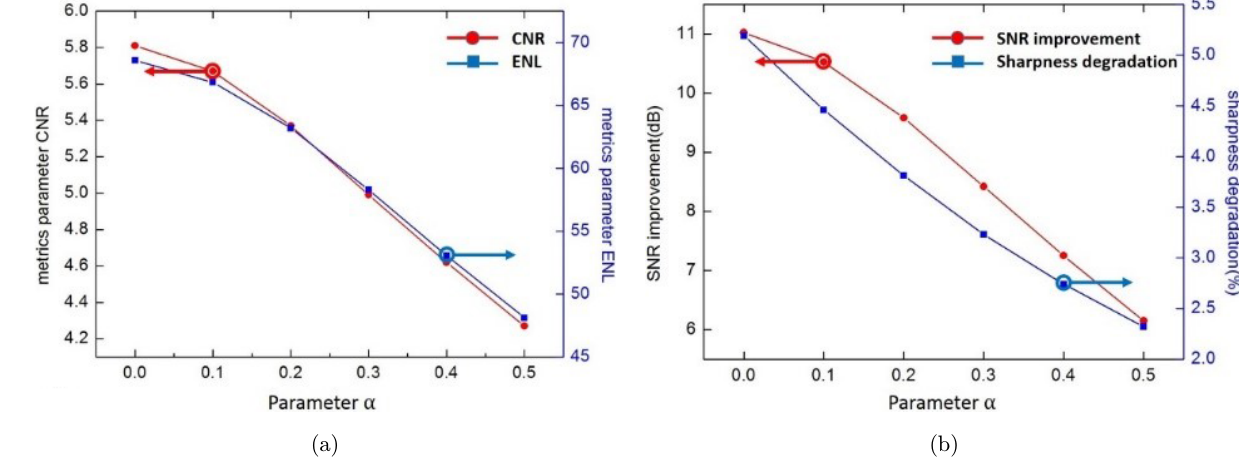
Fig. 4. Diagram of four metrics vs parameter (cid:1) (when (cid:2) ¼ 5 : 0, K ¼ 1 : 2). (a) Calculated CNR and ENL improvement of the image when (cid:1) varies from 0.0 to 0.5. (b) Calculated SNR increasing and sharpness degradation of the image when (cid:1) varies from 0.0 to 0.5.